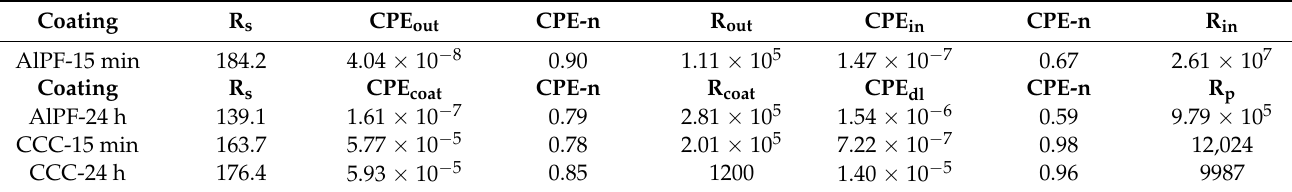
Table 2. EIS fitted data of flash-PEO and CCC-coated AZ31B alloy following immersion in 0.5 wt.% NaCl (R given in Ω cm 2 , CPE given in S s − n cm − 2